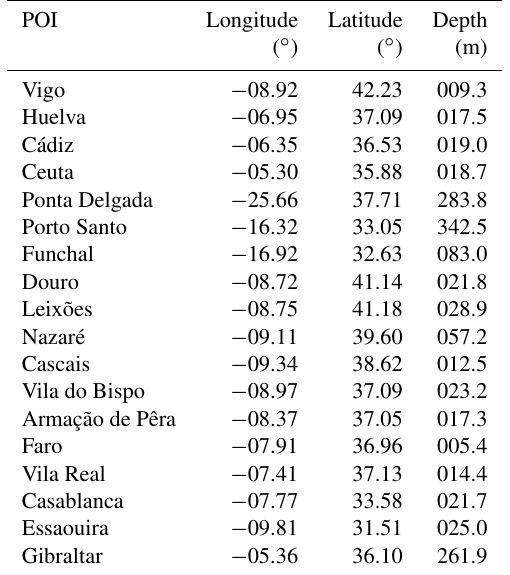
Table 5. Points of interest used in this